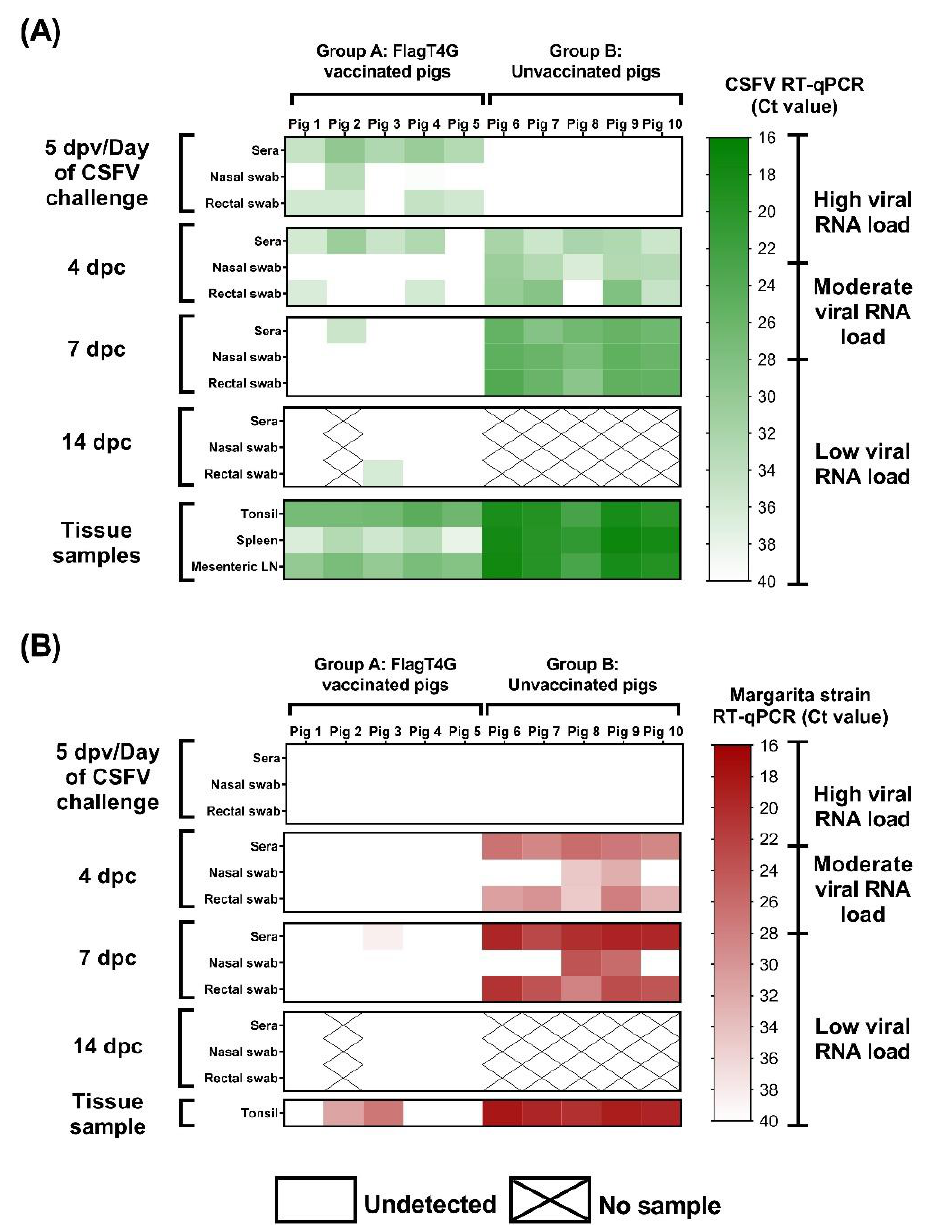
Figure 4. Detection of viral RNA by RT-qPCR. Samples from vaccinated and unvaccinated pigs were evaluated by the pan-CSFV ( A ) and the specific Margarita strain ( B ) RT-qPCR assays. Results are shown in a colorimetric scale representing the Ct value in green and red for the pan-CSFV and Margarita tests, respectively.